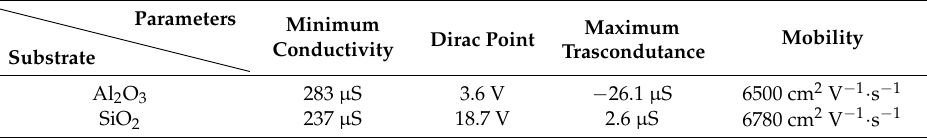
Table 1. Significant parameters of graphene FETs on different substrates.